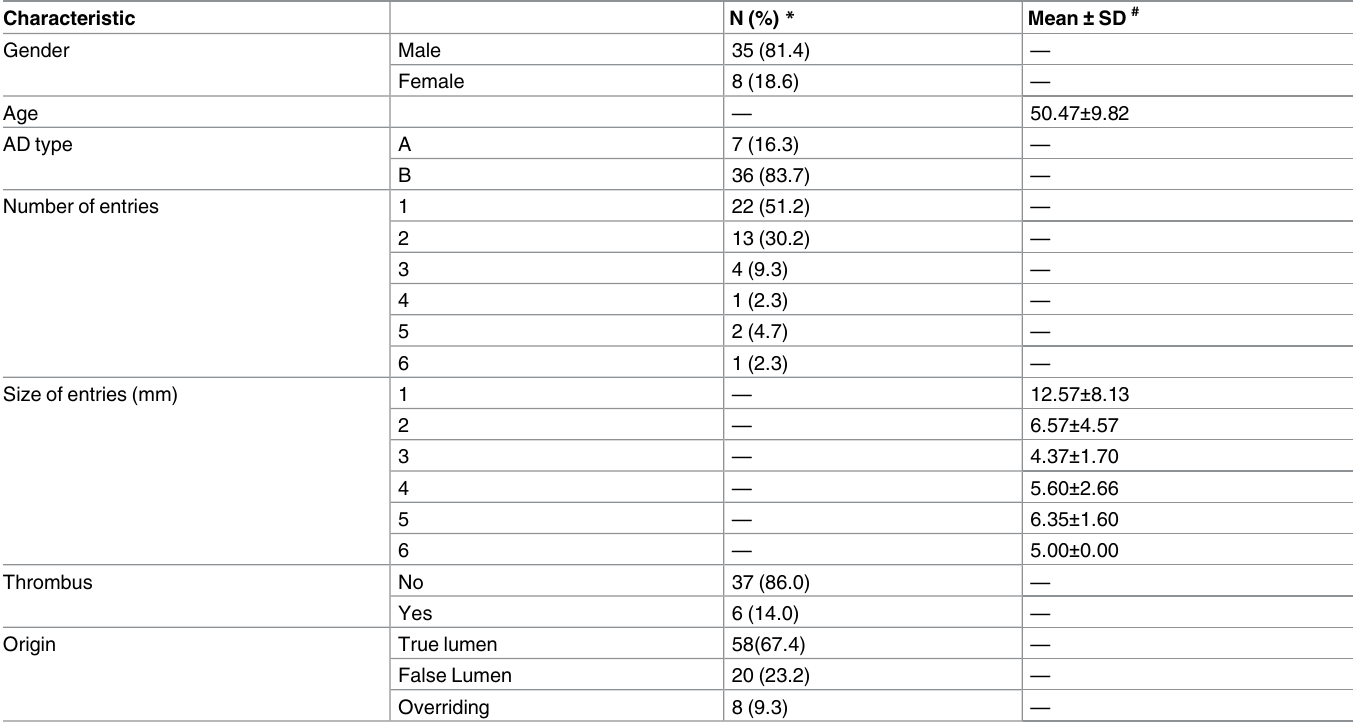
Table 1. Characteristics of study population.